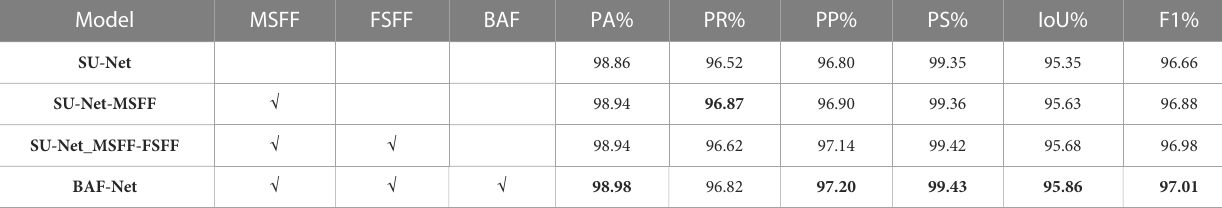
TABLE 7 Comparison of pepper segmentation results of four models on the dataset.